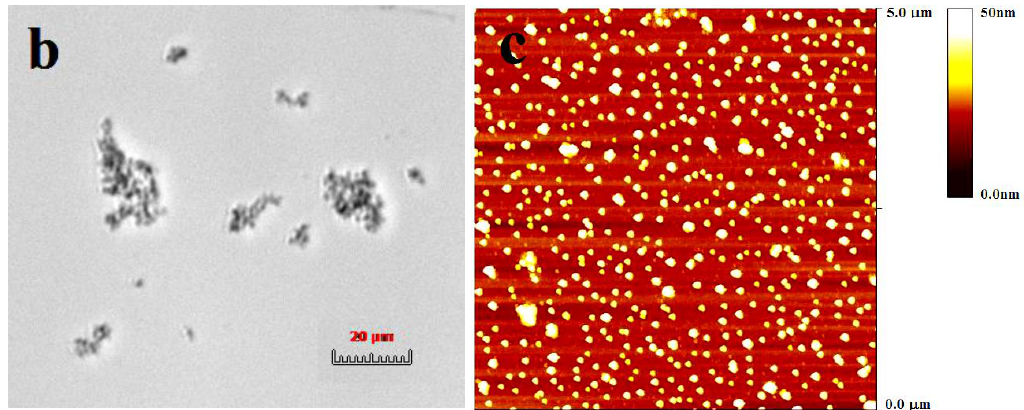
Figure 8. Optical picture of vials containing CMI / BSA complexes prepared at pH = 4.00 (left) and 2.60 (right) after storage at room temperature for one week ( a ). Optical microscopic images of insoluble complexes of CMI / BSA at C NaCl = 10mM at pH = 4.0 and ratio (r) = 1:5 ( b ). Atomic force microscopic height (AFM) image of CMI/BSA complexes with CMI/BSA ratio (r) = 1:5, C NaCl = 10 mM and pH = 2.6 ( c ).